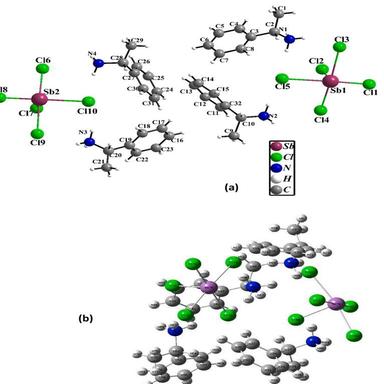
(a) Asymmetric unit of the crystal (C8H12N)42 (b) Theoretical optimized geometry.